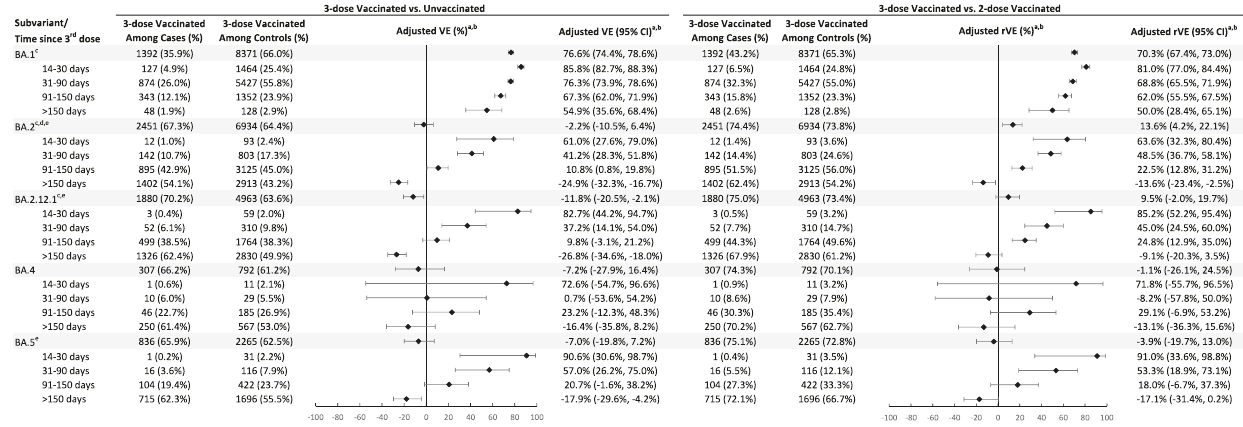
Fig. 2 | Adjusted vaccine effectiveness (VE) and relative vaccine effectiveness (rVE) of mRNA-1273 against infection with omicron subvariants by time since 3rd dose vaccination. Adjusted VE of three doses of mRNA-1273 and adjusted rVE of three versustwodoses ofmRNA-1273and their95%con fi denceintervalsagainst infection with SARS-CoV-2 omicron subvariants. Sample size for each analysis equals the number of three-dose vaccinated divided by the percentage of three- dosevaccinated. Symbolsrepresentthe adjustedvaccine effectivenessoradjusted relative vaccine effectiveness. a When the OR or its 95% CI was >1, the VE/rVE or its 95%CI wastransformedas([1/OR] – 1)×100. b Adjustedforage,sex, race/ethnicity,